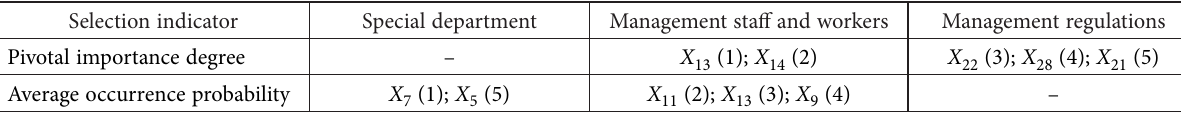
Table 7. Sensitive basic events in the reliability model Selection